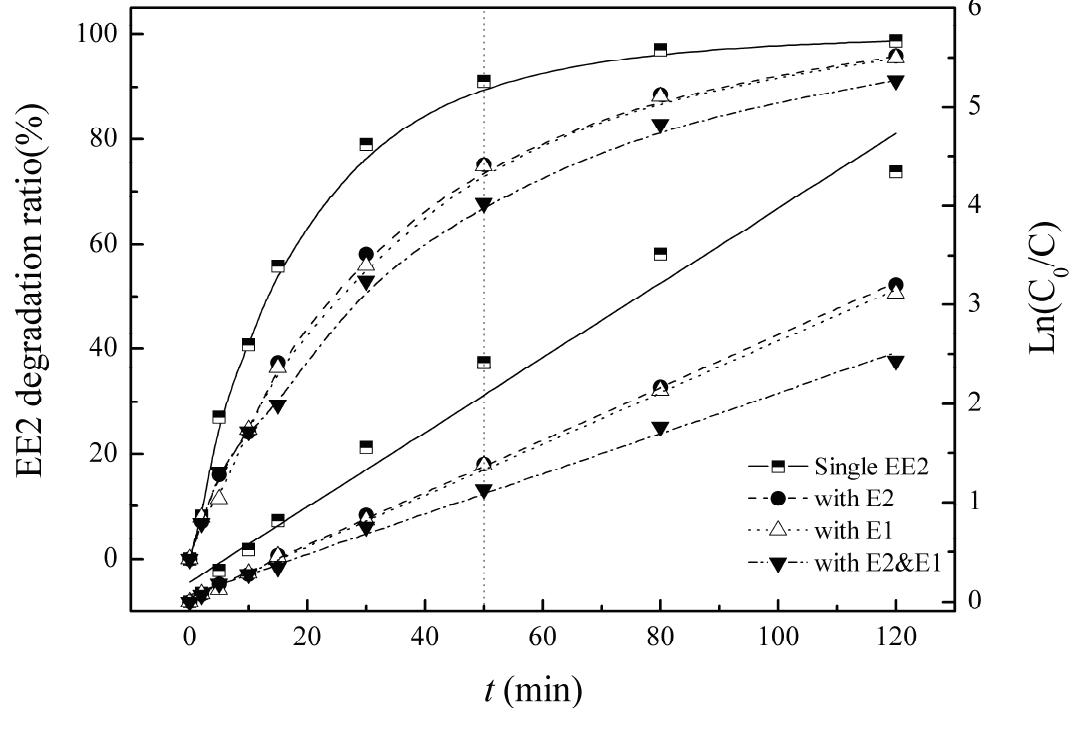
Figure 4. Degradation and reaction kinetics for EE2 under single and combined estrogen pollution. Table 3. Kinetic parameters of degradation of EE2 under single and combined estrogen